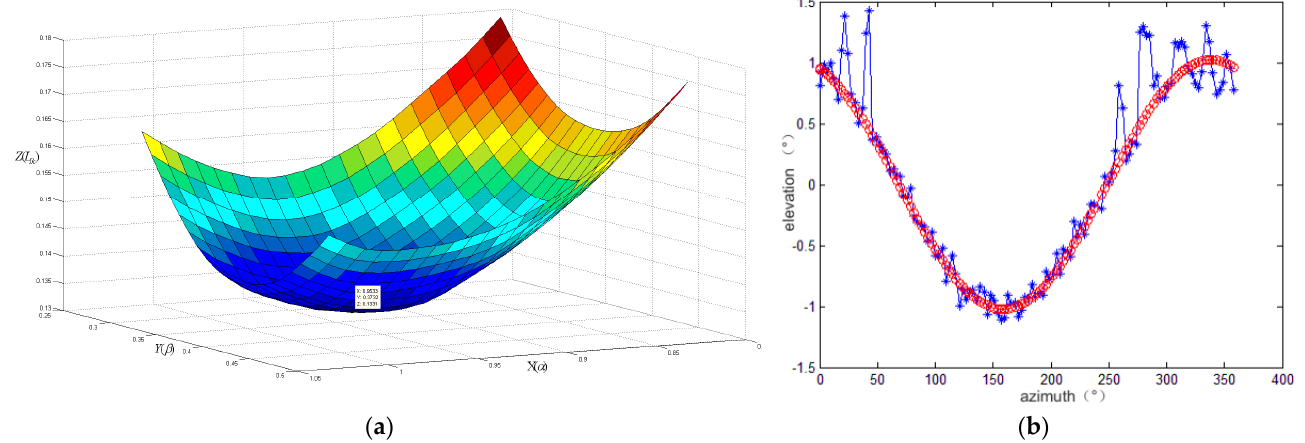
Figure 9. Comparison of pitch angle error measurement values and fitting calculation values between the line-of-sight and the sea–sky line.